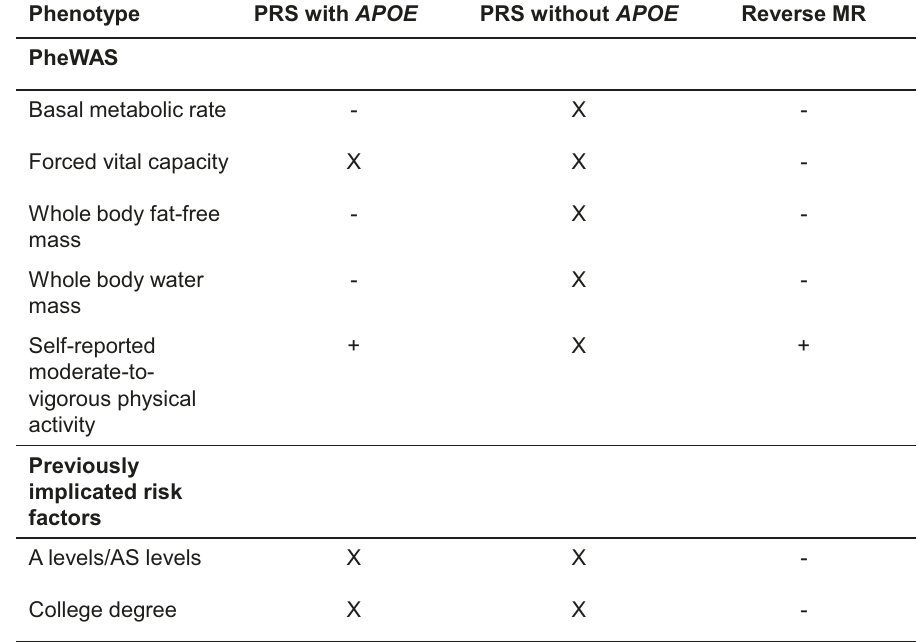
Fig. 7 | Association of Alzheimer ’ s disease polygenic risk score with the phe- nome, and estimated effect of each phenotype using Mendelian randomiza- tion. These fi ndings showed evidence of association in the MR framework, following a correction for multiple testing using a strategy controlling for the false